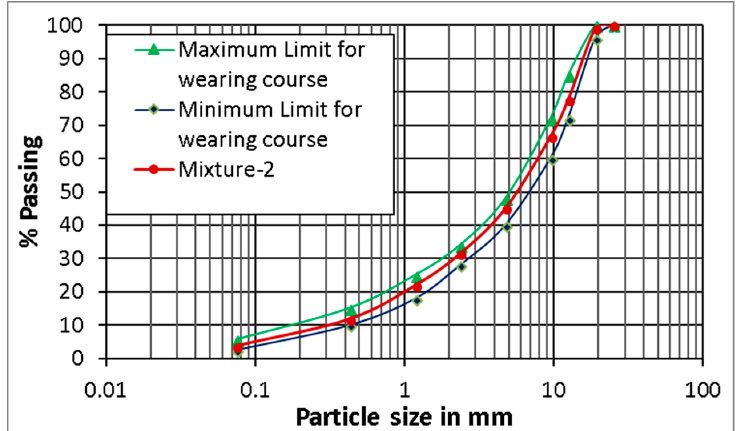
Figure 3. Gradation of wearing course plant loose mixture (mixture 2).